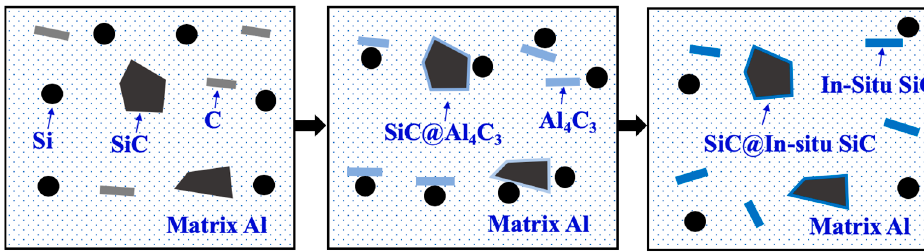
Figure 14. Schematic diagram showing the formation mechanism of the SiC core-shell structure (SiC@In situ SiC).